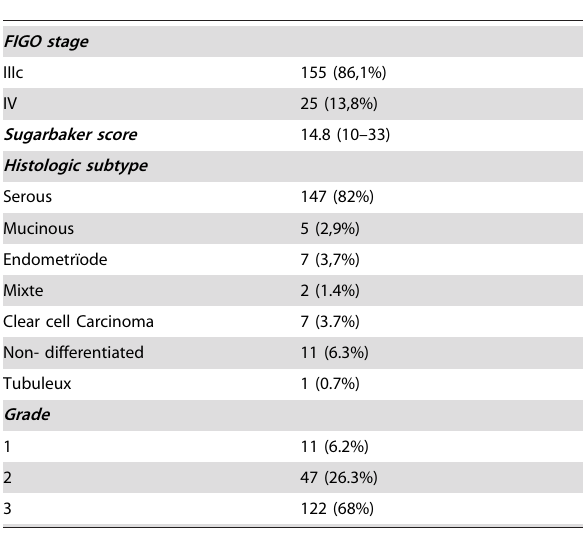
Table 2. Surgical and tumor characteristics.